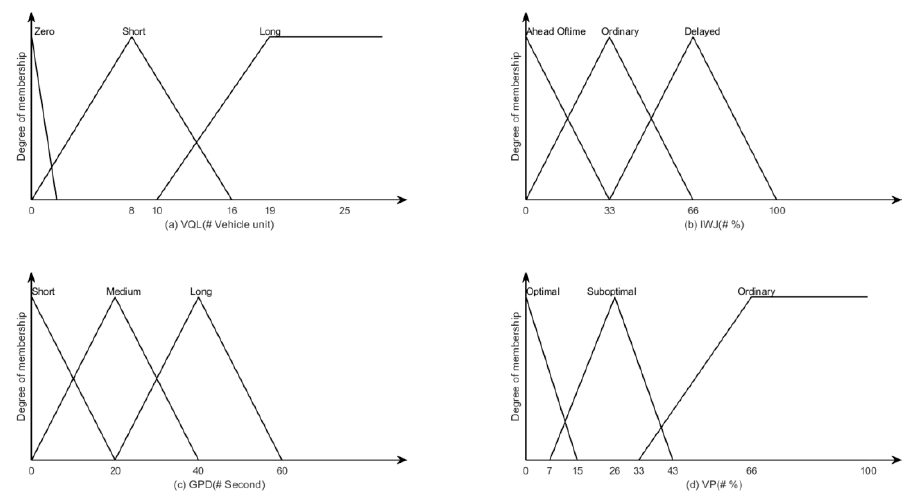
Figure 2. The input fuzzy membership of the fuzzy logic system.